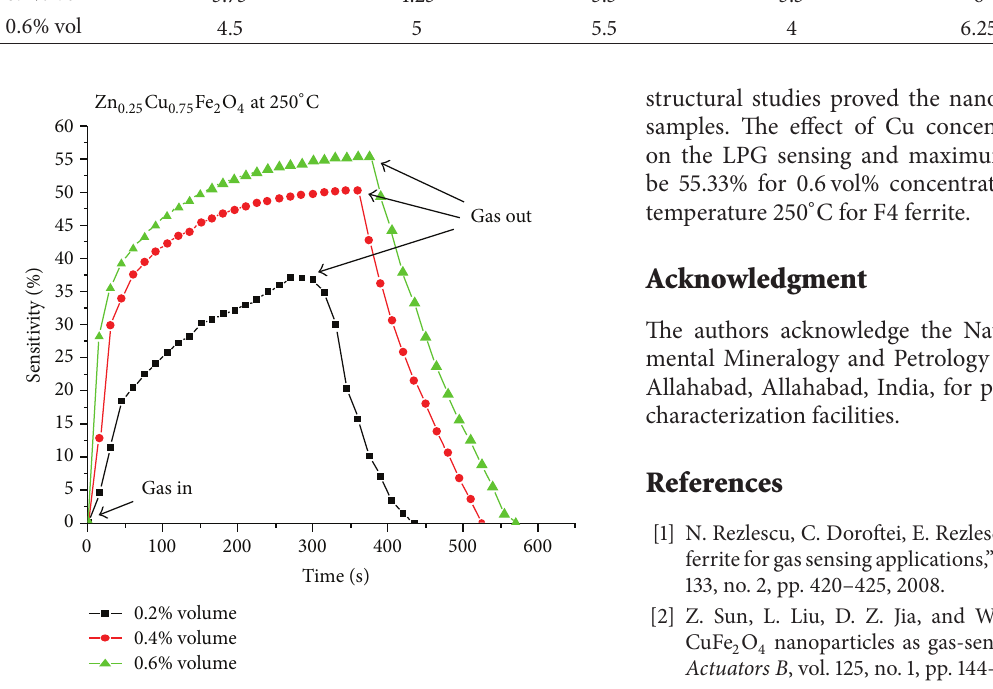
Figure 4: Transient response characteristics of Zn 0.25 Cu 0.75 Fe 2 O 4 at operating temperature of 250 ∘